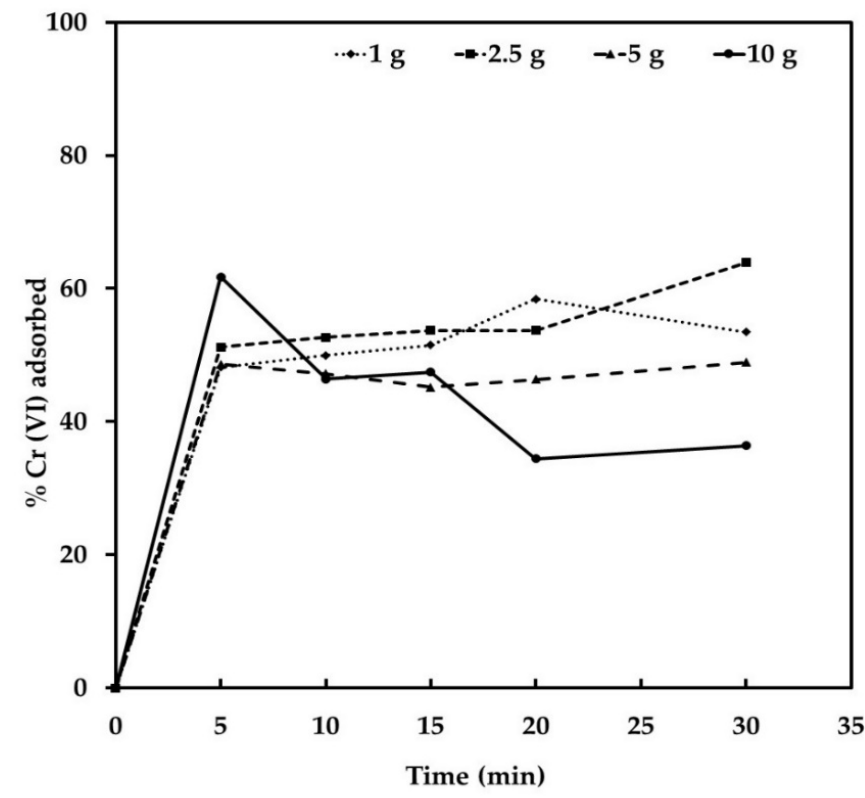
Figure 4. Effect of contact time on the adsorption of Cr (VI) from industrial wastewater using JTT; temperature 25 °C and pH 3.